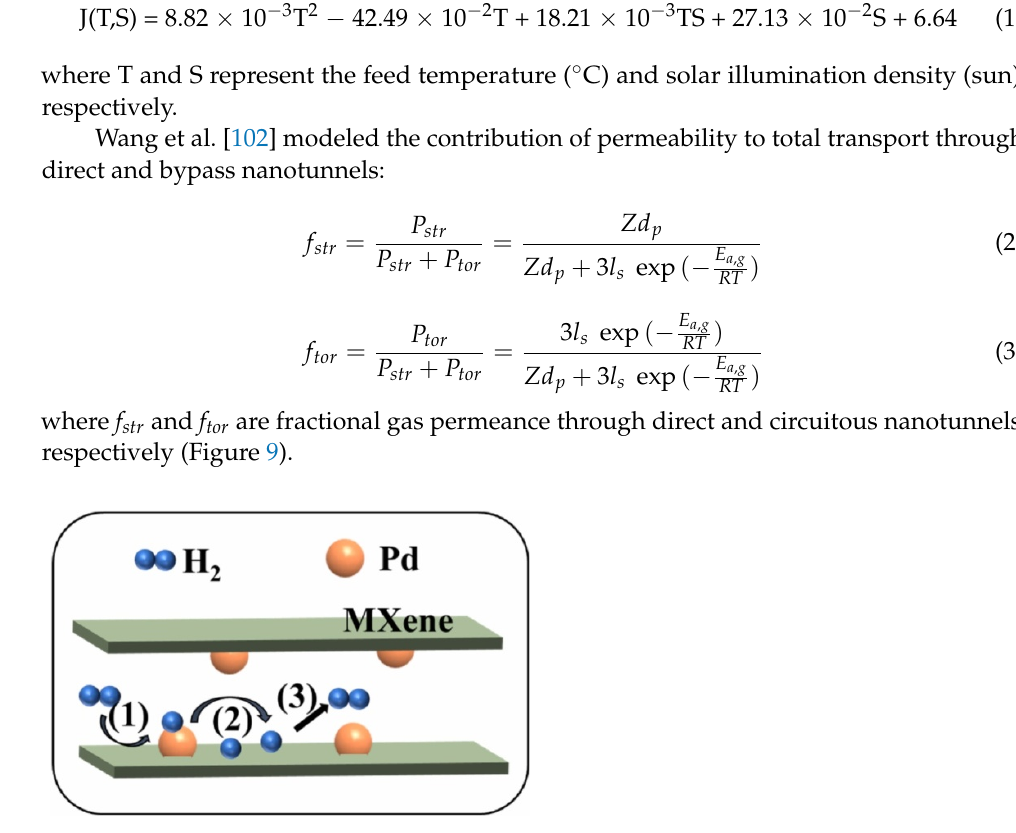
Figure 9. Schematic illustration of the H-spillover process, diagram taken from